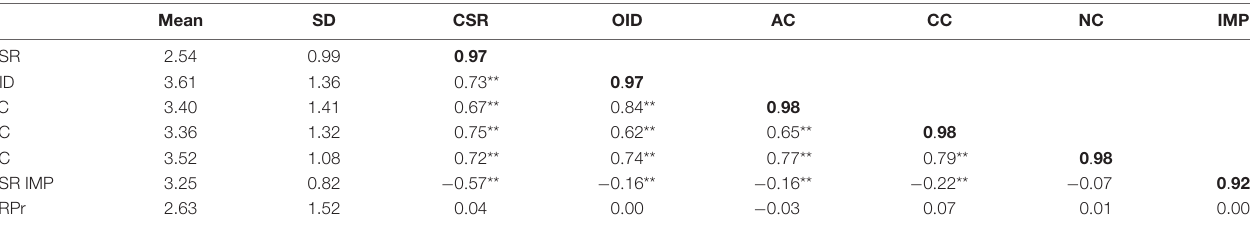
TABLE 3 | Mean, standard deviation, correlation, and